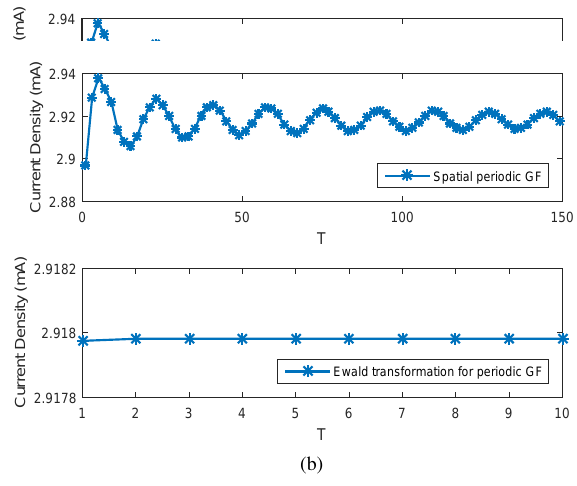
Figure 1: Maximum current density on 4 mm width square patch in 15.2 mm square unit lattice cell at 11 GHz, as a func- tion of T . (a) Using spatial periodic Green’s function. (b) Using Ewald’s